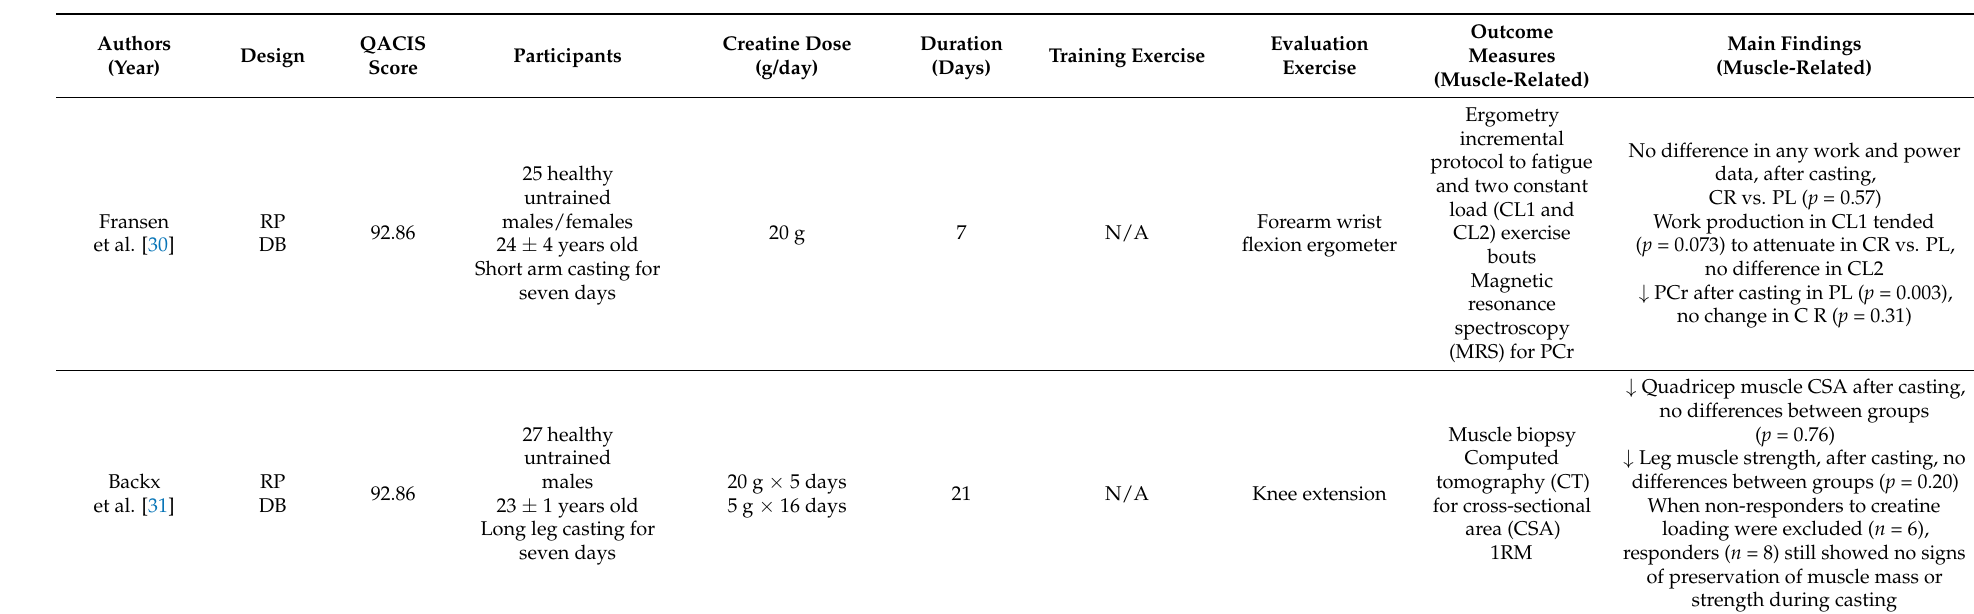
Table 3. Studies recruiting healthy mimic immobilization